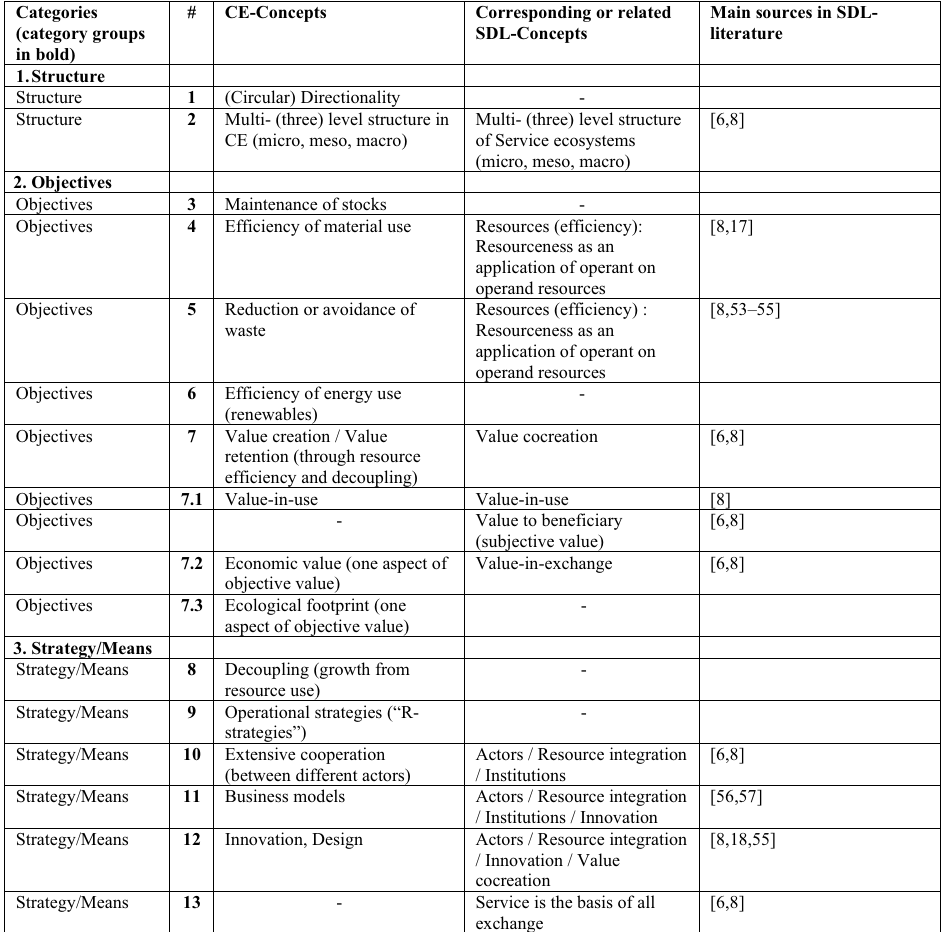
Table 4. Mapping between CE core concepts and related SDL core